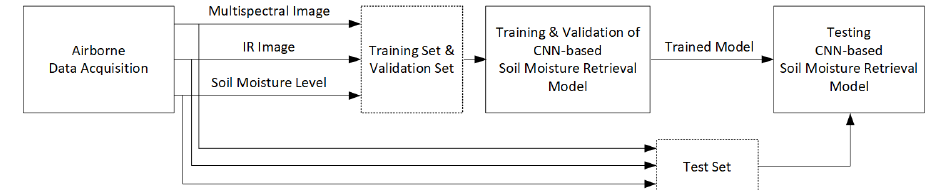
Figure 3. Flowchart of the CNN-based soil moisture retrieval model development.